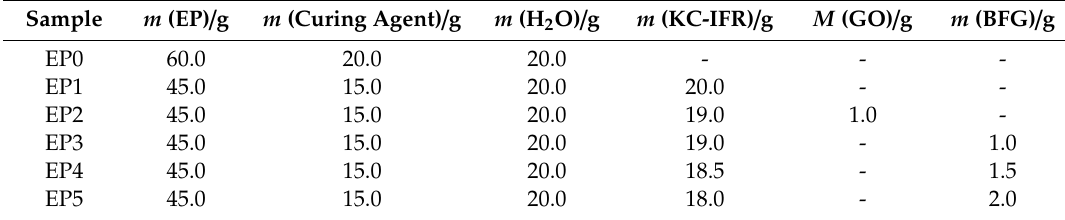
Table 1. Formulation of